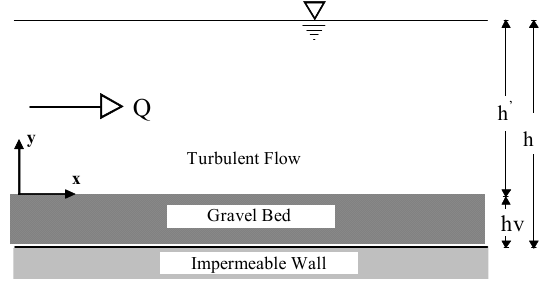
Figure 2. Turbulent flow characteristics Photogragh 1. Gravel bed with h v = 2